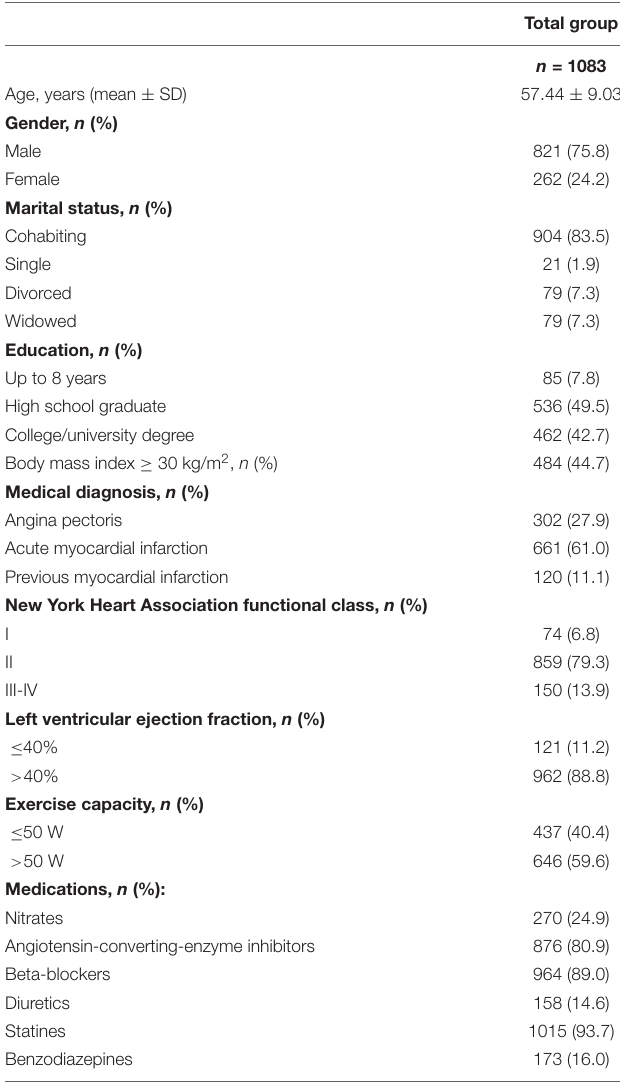
TABLE 1 | Characteristics of all study